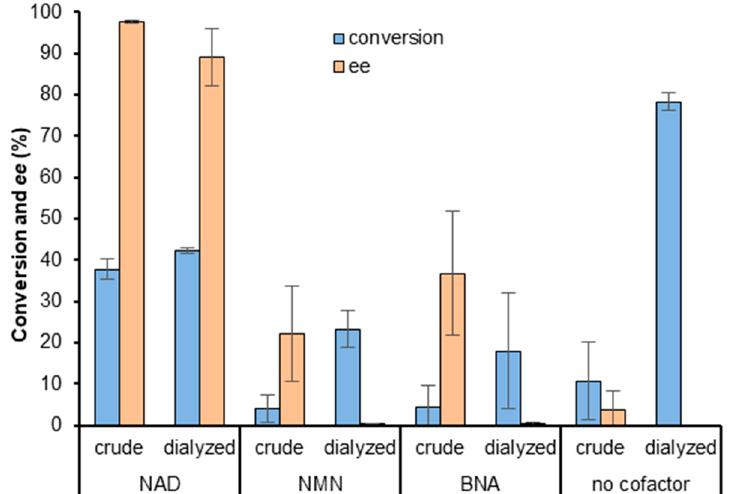
Figure 3. HLADH-catalyzed reduction of 4-phenyl-2-butanone with the Rh complex recycling system using either NAD, NMN, BNA, or no cofactor. HLADH was used as lyophilized cell-free extracts (crude) or dialyzed (conversion, blue; ee , orange). Reaction conditions: 100 mM KPi pH 7.0, HLADH (2 U), [cofactor] = 2.2 mM (where applicable), [Cp*Rh(bpy)(H 2 O)] 2+ = 0.52 mM, [HCO 2 Na] = 52 mM, [4-phenyl-2-butanone] = 16.7 mM, shaken at 30 °C, 800 rpm, 18 h.